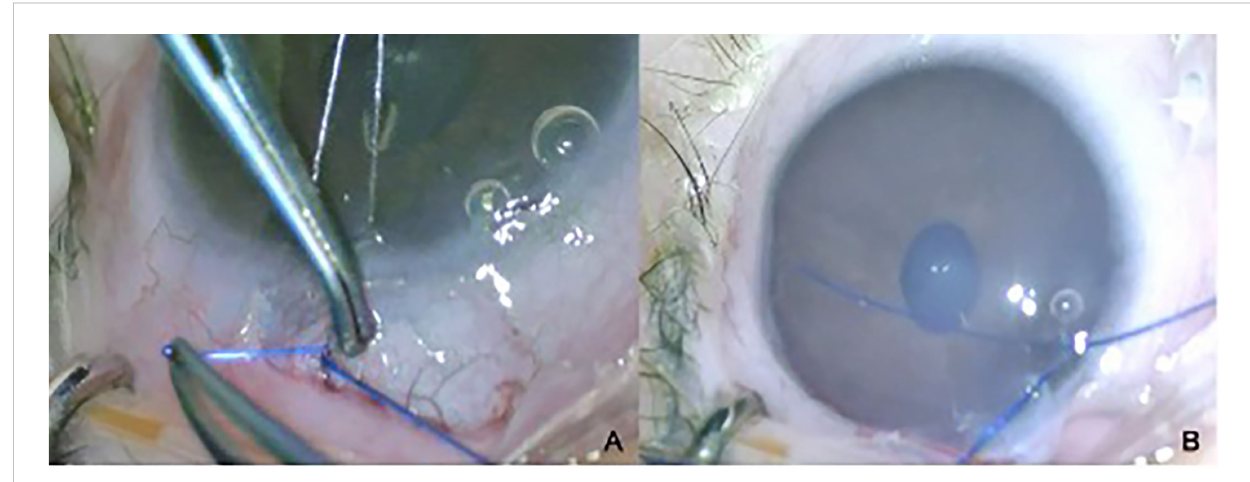
FIGURE 4 Completion of circumferenital advancement of 6-0 Prolene suture (A) and externalization of the suture via the side port to be pulled as an alternative method (B) .